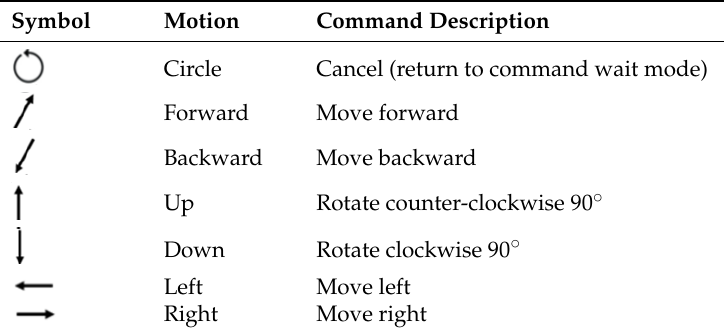
Table 1. Basic patterns for gesture recognition.